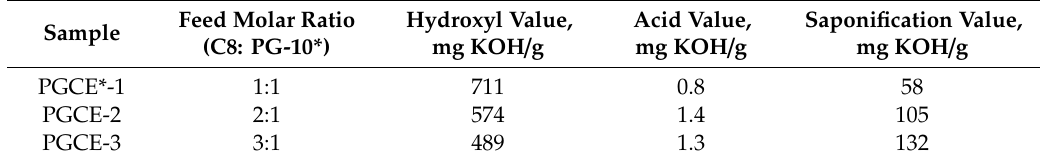
Table 2. Chemical features of polyglyceryl-10